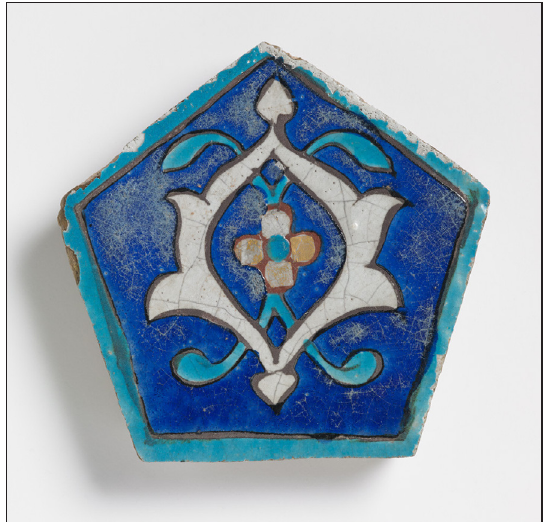
Fig. 16 : Pentagonal tile, fritware with cuerda seca decoration, Iran (Khargird), 1425–75. F55A, given by Miss E. G. Tanner in 1926. © Holburne Museum, Bath. Photo: